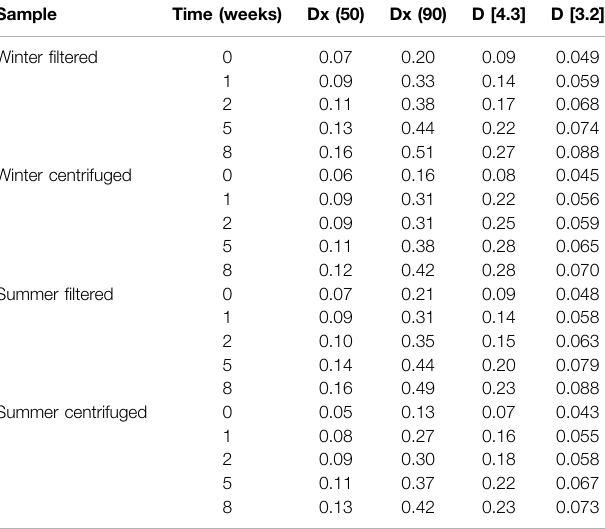
TABLE 3 | Droplet size (µm) of the emulsions during storage.